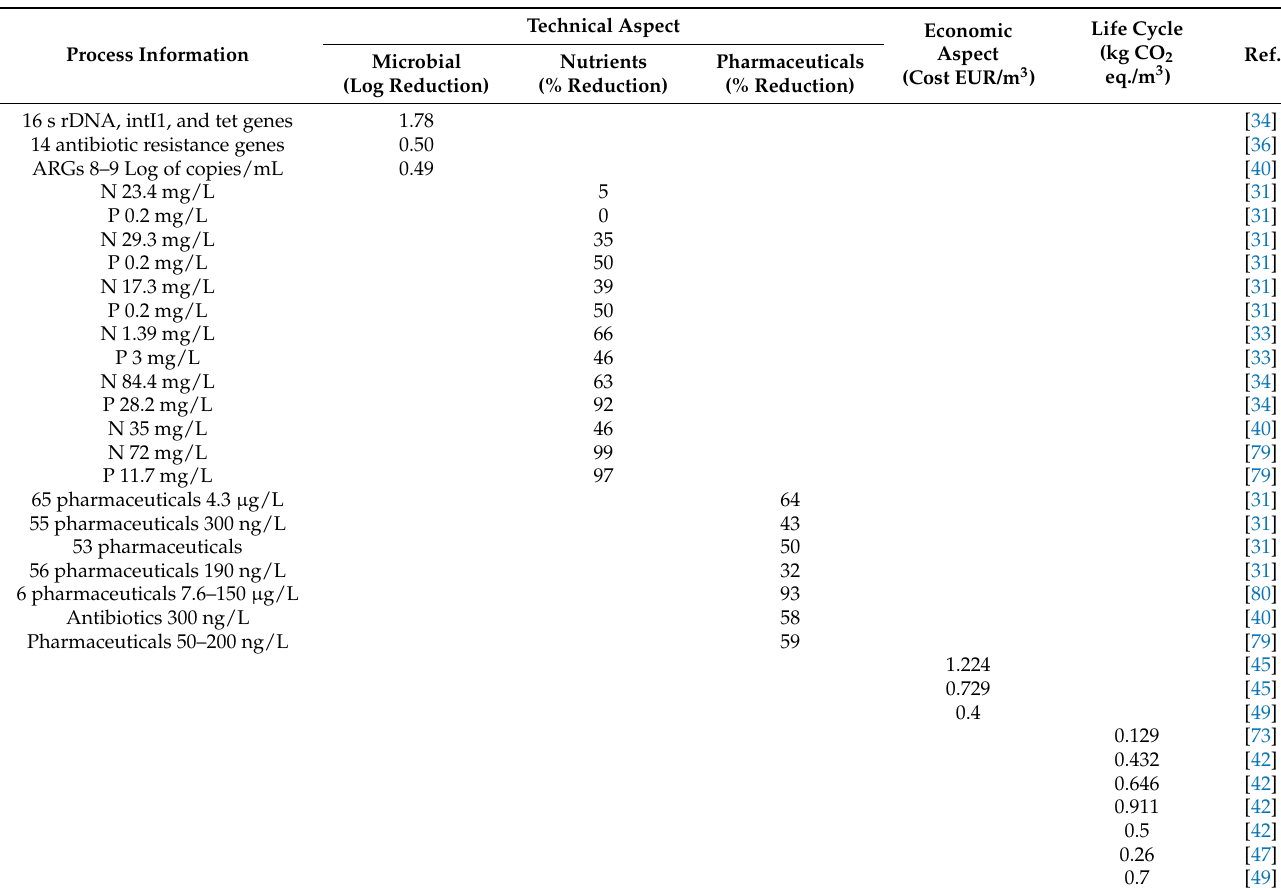
Table A4. Literature data used for scoring the constructed wetlands